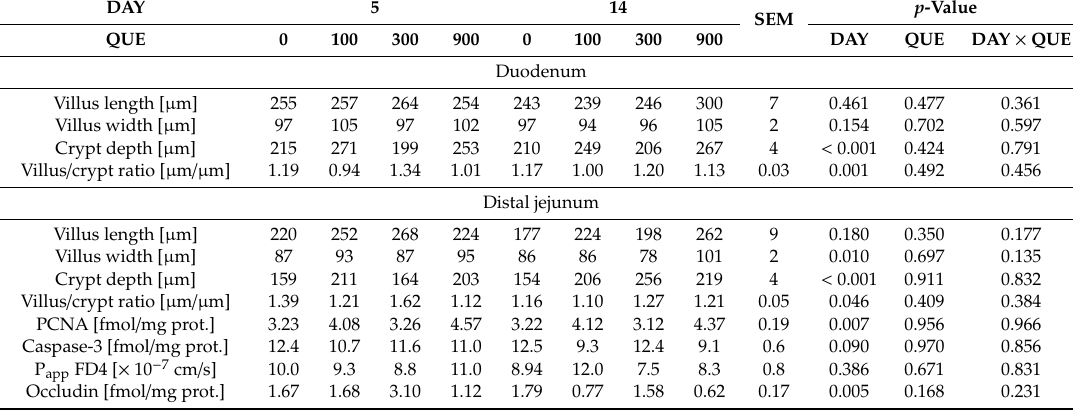
Table 8. The e ff ect of quercetin at doses of either 0, 100, 300, or 900 mg / kg diet (QUE) during the first 14d post-weaning on the small intestinal histomorphology, barrier function and tight junction and mitotic / apoptotic protein abundance in piglets at d5 and d14post-weaning (DAY) ( n = 8).